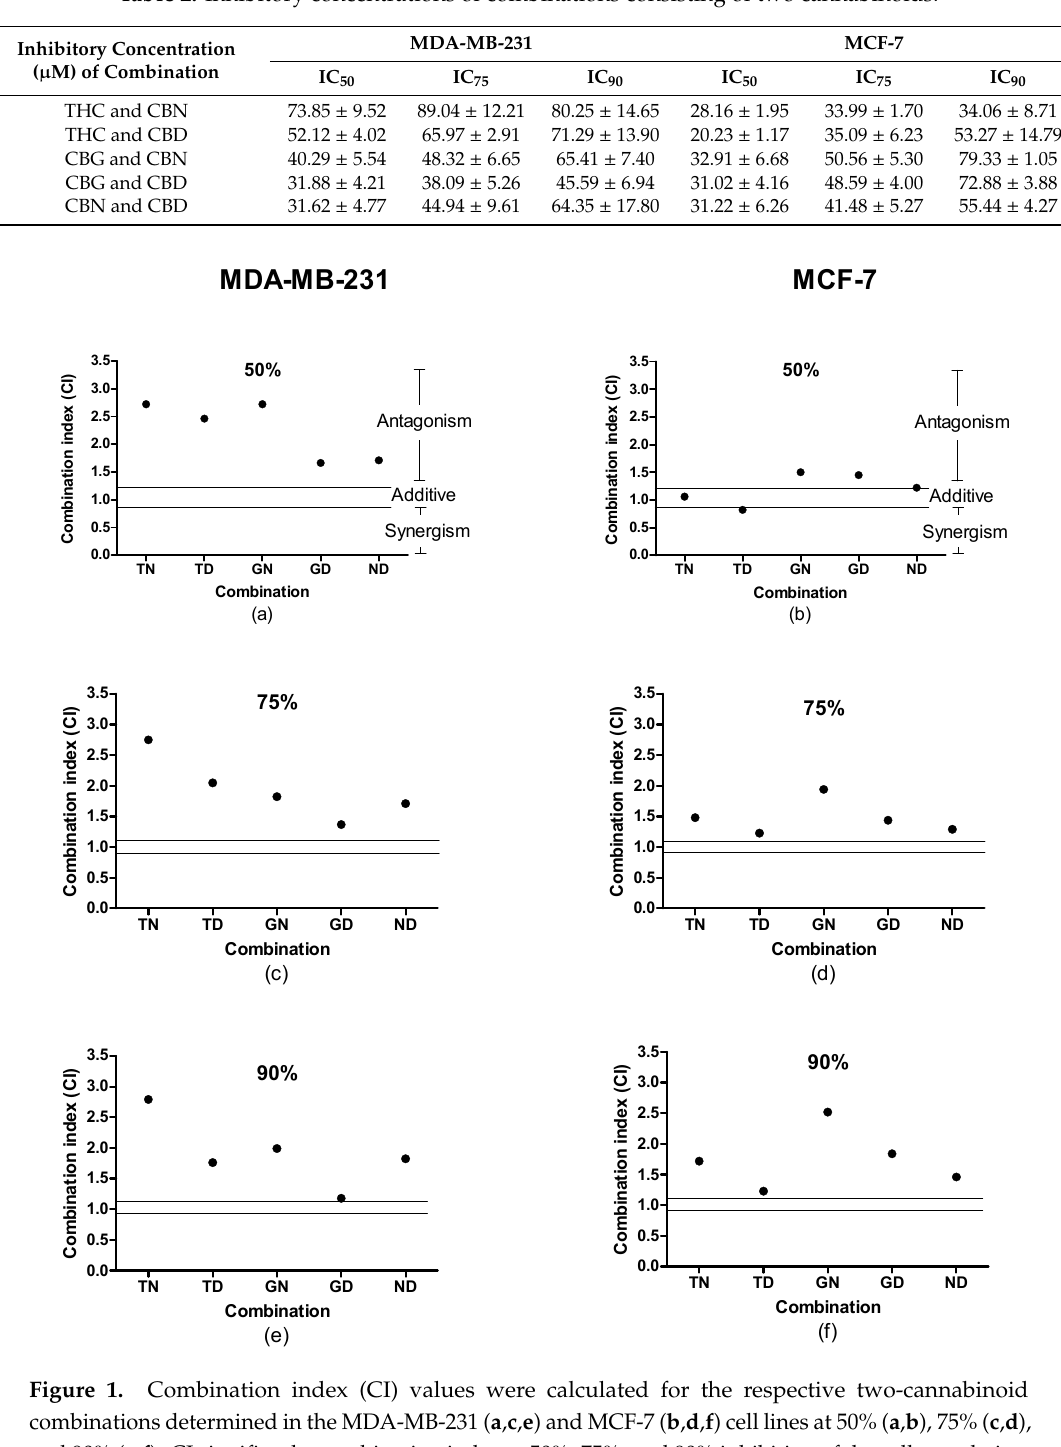
Table 2. Inhibitory concentrations of combinations consisting of two cannabinoids.